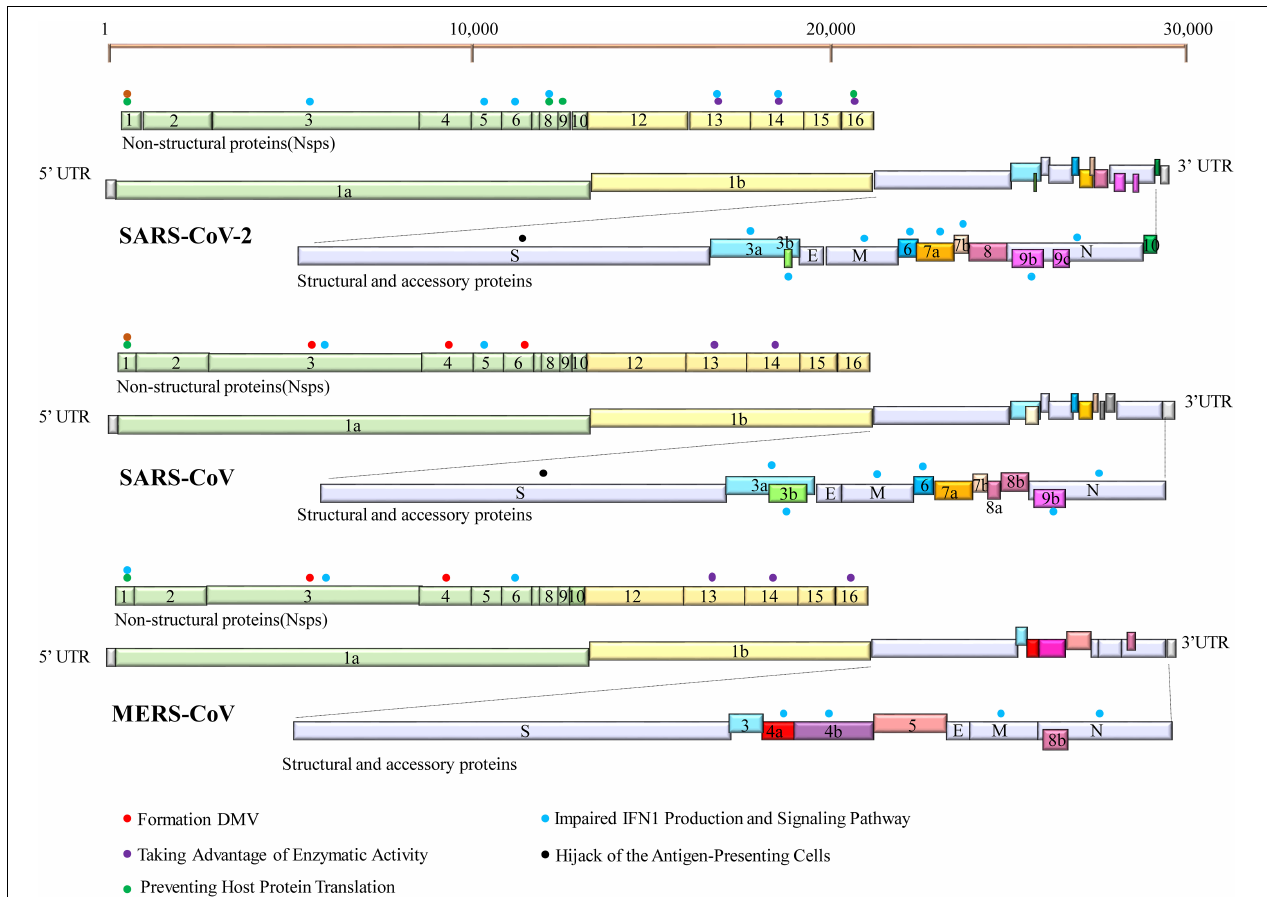
FIGURE 1 | Genome organization of SARS-CoV-2, SARS-CoV, and MERS-CoV. The common trait is that their genomes encode two replicase polypeptides pp1a and pp1b translated from ORF1a and ORF1b. The polypeptides undergo a series of proteolytic cleavages to form 16 non-structural proteins encoded by the first two-thirds of the genome. The remaining one-third 3 (cid:48) region of the viral genome encodes viral structural proteins [spike (S), membrane (M), envelope (E), and nucleocapsid (N) proteins] and virus-specific accessory proteins. Accessory proteins are interspersed within these structural proteins. Some proteins can inhibit innate immune responses by employing a variety of tactics. Their locations are indicated with specific-colored spheres. The different colored spheres represent the different immune evasive strategies. Each virus-encoded multifunctional protein, employing multiple different activities to suppress innate immunity